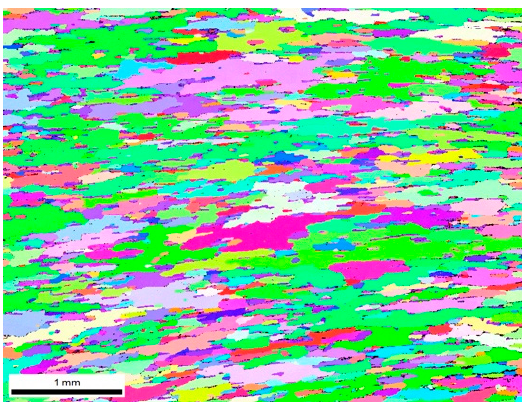
Figure 2. ( a ) Optical microstructure (scale bar is 100 μ m) and ( b ) distribution of particles (scale bar is 10 μ m) in the as-received aluminum alloy AA5083.